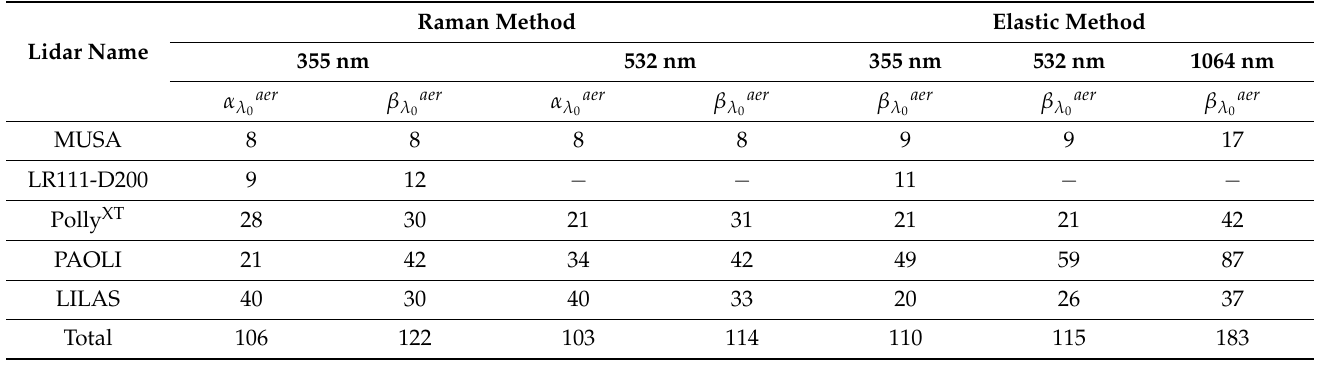
Table 3. Number of considered cases grouped by lidar system and by the retrieval